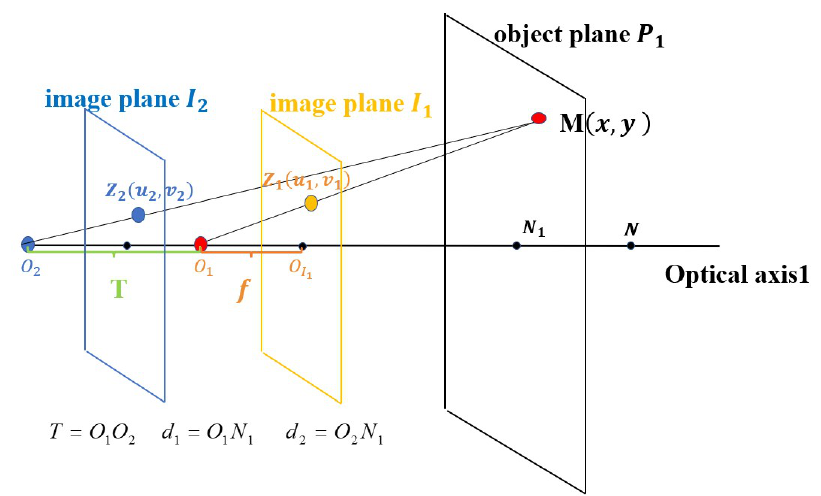
Figure 4. The projection coordinates and related physical quantities corresponding to the object point M when the camera moves along the optical axis with distance T